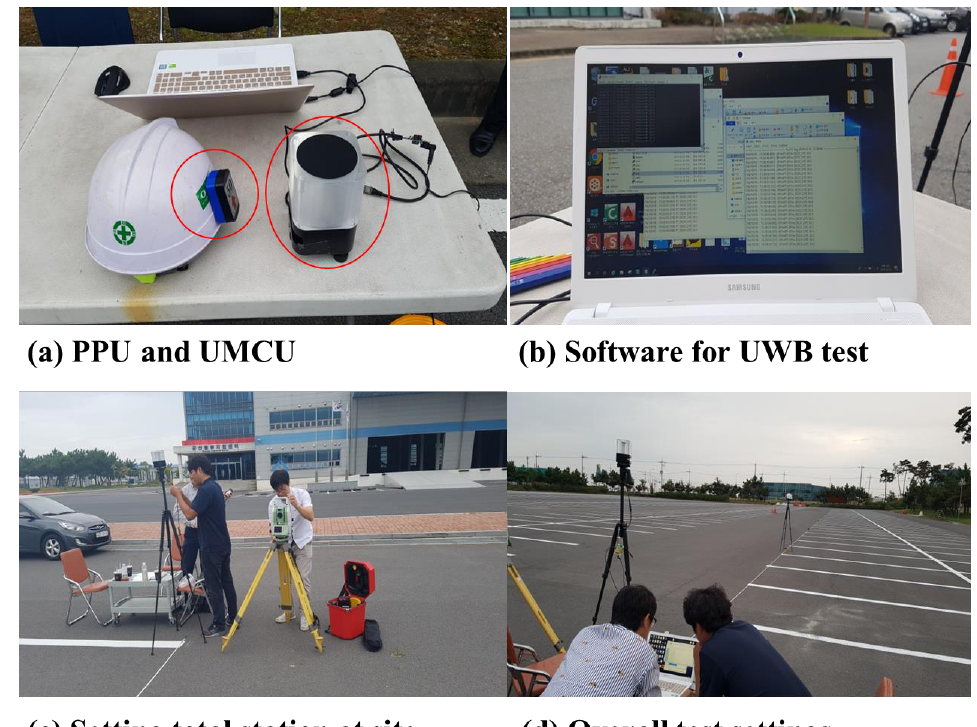
Figure 11. Test environment of recognition rate. ( a ) Pictorial view of PPU and UMCU, ( b ) software for UWB test, ( c ) setting total station at test site, and ( d ) overall setting of recognition test.